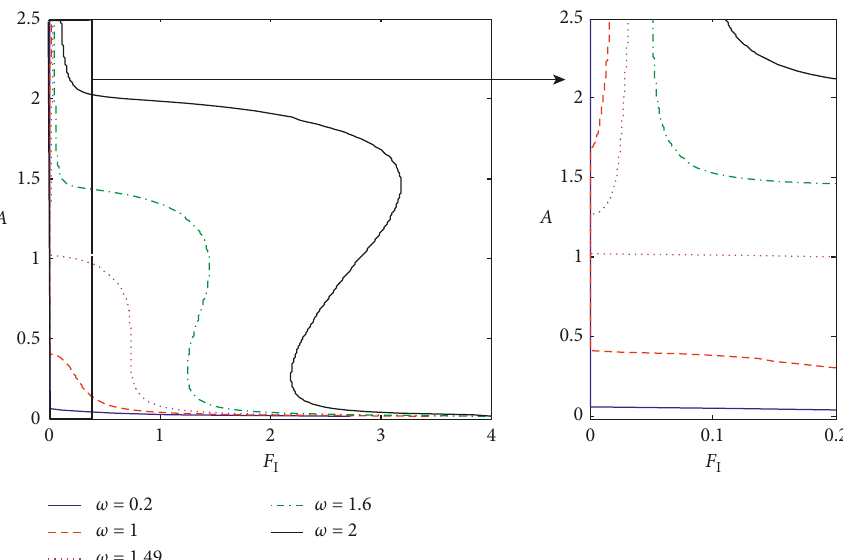
Figure 14: Amplitude-force curves of the system.